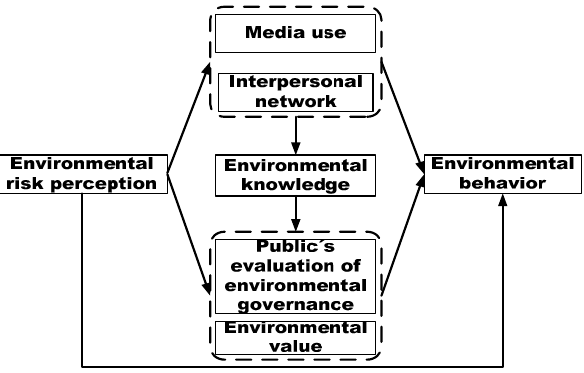
Figure 1. Theoretical framework for factors influencing environmental risk perception on its behavioral responses.